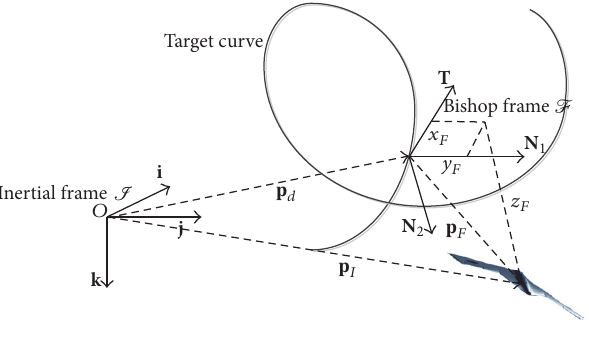
Figure 1: Illustration of the moving frame tracking